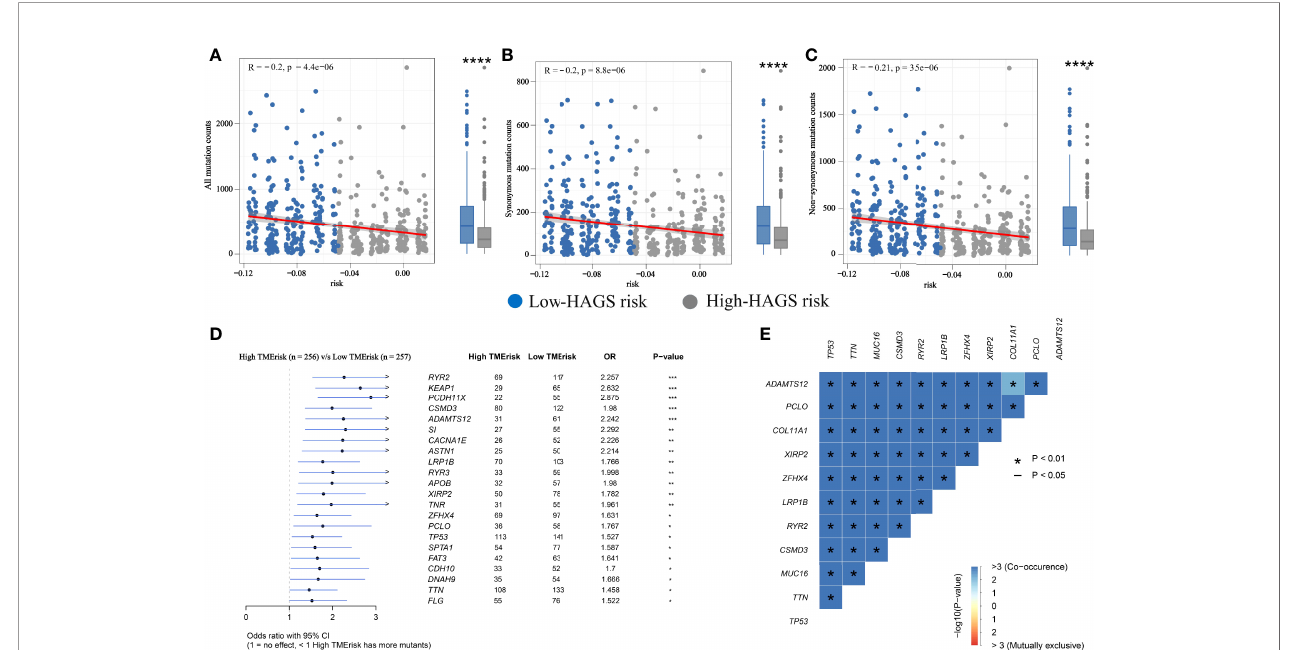
FIGURE 8 | Hypoxia-associated signatures were related to TMB. (A – C) Association between all mutation counts, synonymous mutation counts, non-synonymous mutation counts, and HAGS risk score and their distribution in the low and the high HAGS risk groups. (D) Forest plot of genes mutating differentially between the low and the high HAGS risk groups. (E) Interaction effect of genes mutating differentially between the low and the high HAGS risk groups. *p < 0.05; **p < 0.01; ***p < 0.001; ****p < 0.0001.